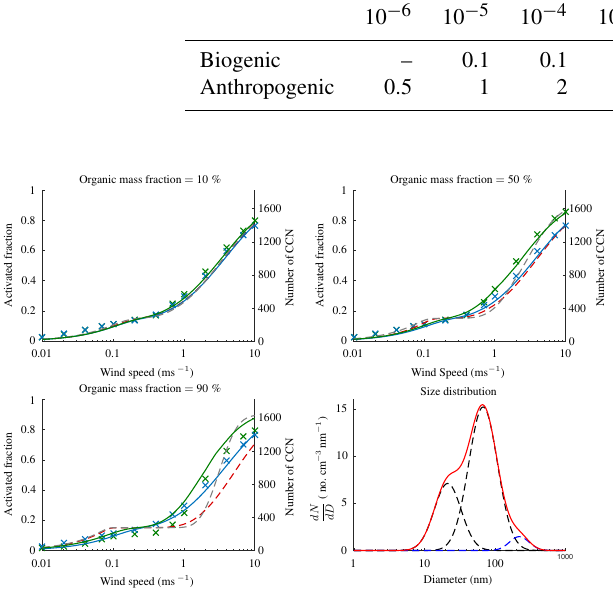
Figure 7. Activated fraction of aerosol particles using the natural environment particle size distribution at a range of vertical updrafts. Three different concentrations of SVOCs are used and are specified above each plot. The crosses show the results from the parcel model and the solid lines show the parameterisation both with (green) and without SVOCs (blue). The effect of assuming multiple mode equi- librium at cloud base instead of the DCP is shown in dashed red and the dashed grey shows the activated fraction neglecting the co- condensation of SVOCs during the ascent up to cloud